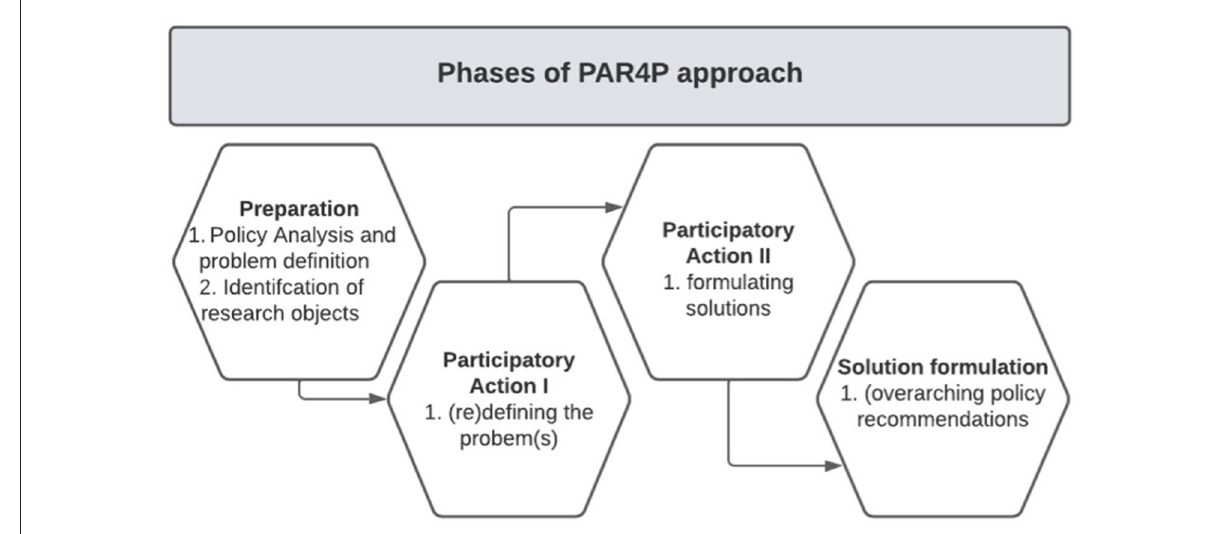
FIGURE2 Original PAR4P method as proposed by Laenens et al. (2019).